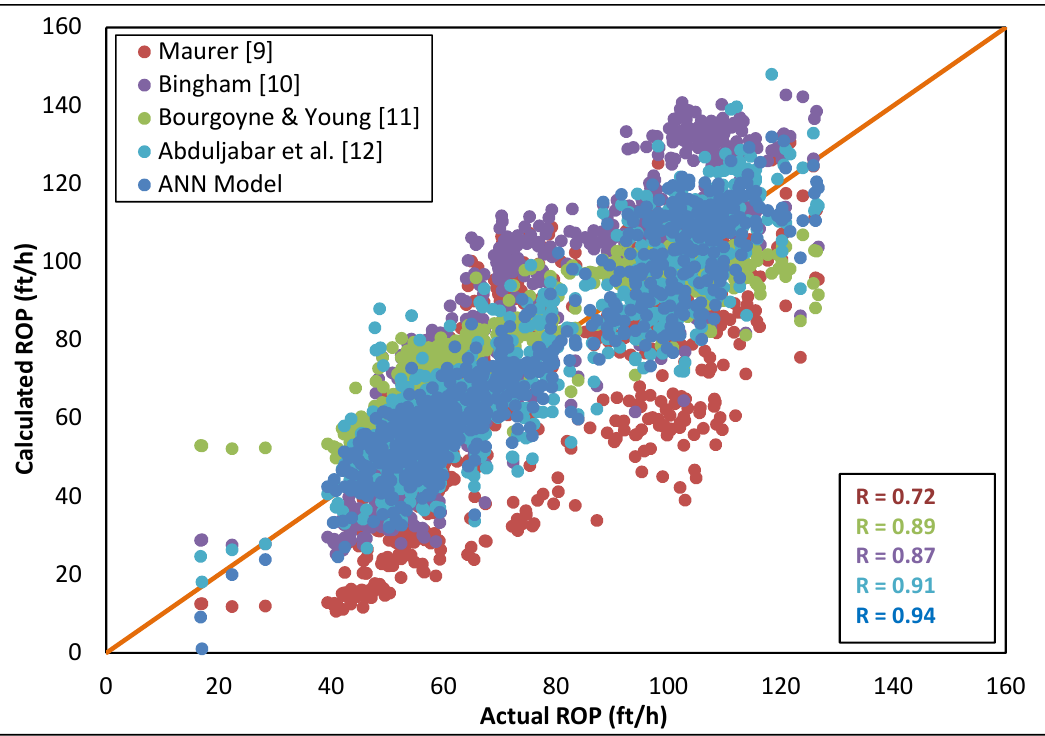
Figure 7. Cross-plot of actual vs. calculated ROP using different ROP correlations using the data set from Well C.